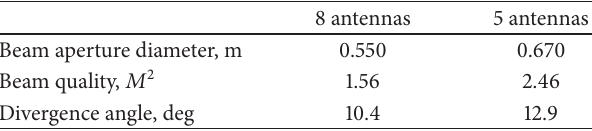
Table 4: Specifications of beam